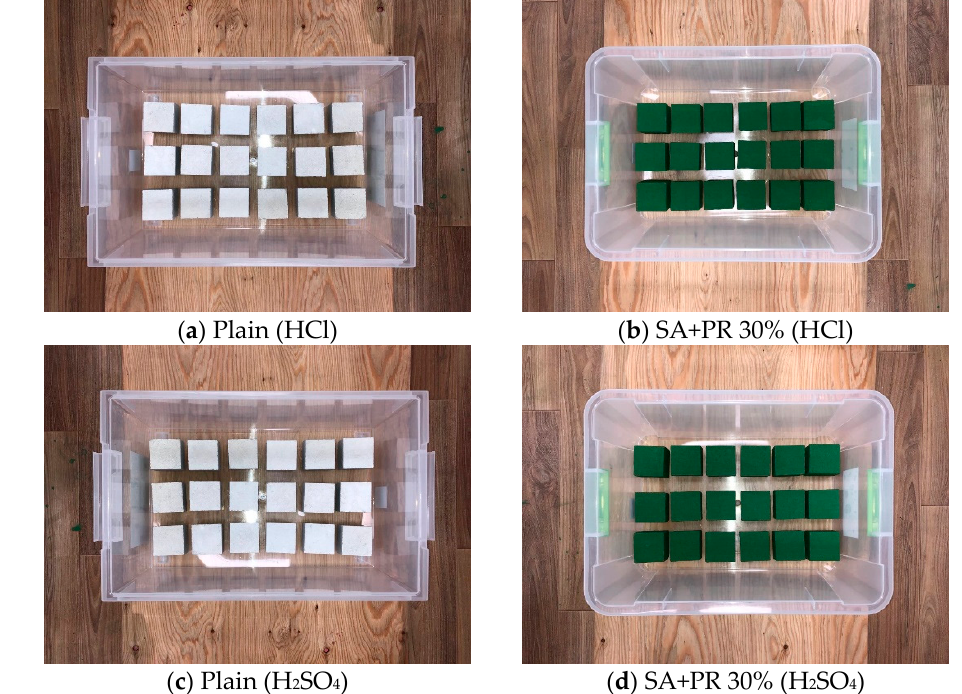
Figure 2. Arrangement of specimens for chemical resistance test.